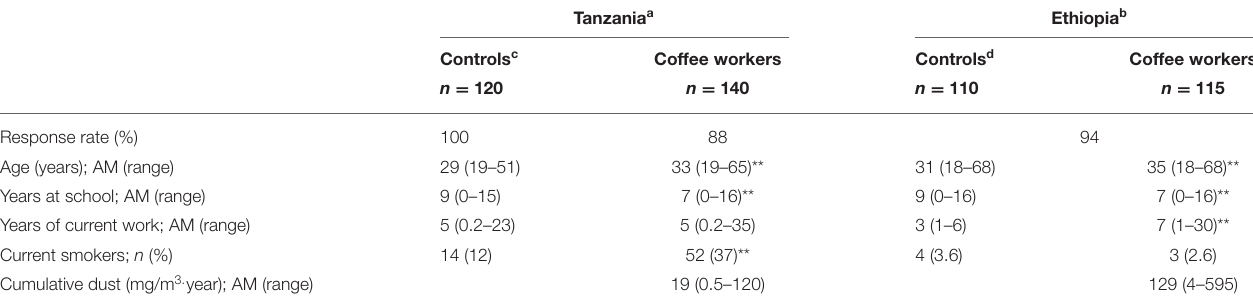
TABLE 2 | Demographic information on the participants in the three studies of respiratory health among male coffee workers in Tanzania and Ethiopia. Tanzania a